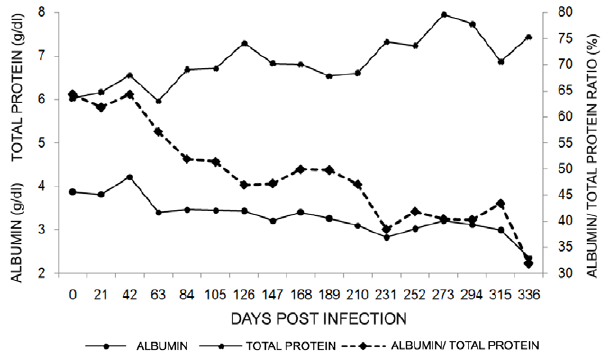
Figure 3. Kinetics of albumin and total protein levels and albumin/total protein ratio in a Leishmaniainfantum infected Thrichomys laurentius (7548). Day 0 indicate the values obtained before the experimental